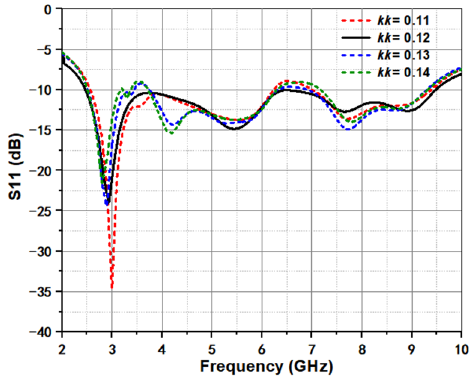
Figure 4. Simulated return loss under different exponential index kk .